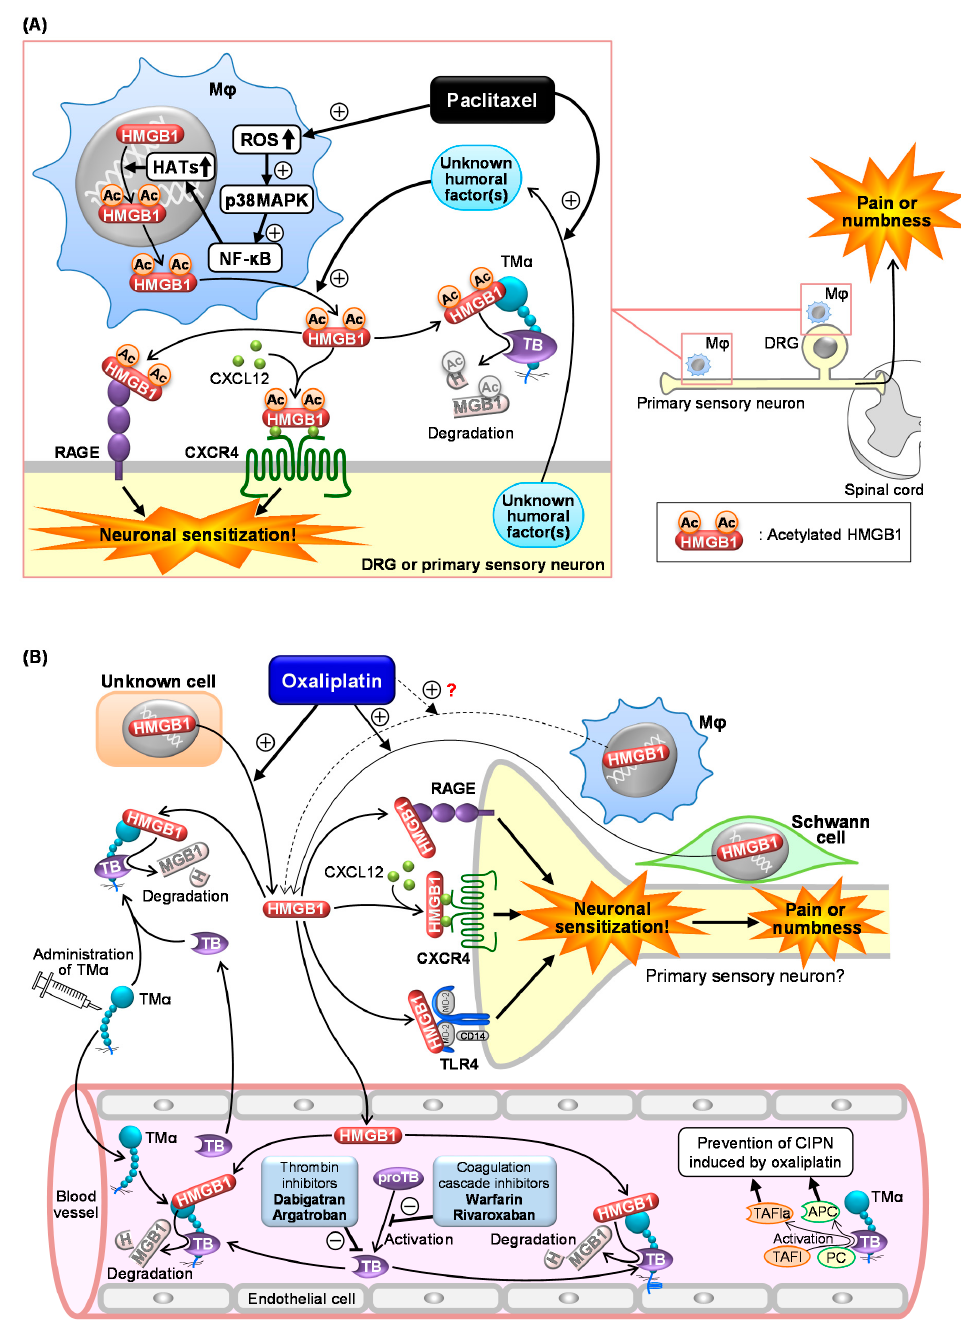
Figure 2. Scheme of the mechanisms underlying chemotherapy-induced peripheral neuropathy (CIPN) in mice treated with paclitaxel ( A ) or oxaliplatin ( B ). ( A ) Paclitaxel causes macrophage (M φ ) accumulation in the dorsal root ganglion (DRG) and sciatic nerves (primary sensory neurons) and upregulates histone acetyltransferases (HATs) via the ROS/p38MAPK/NF- κ B pathway, resulting in acetylation and cytoplasmic translocation of nuclear HMGB1 followed by its secretion. Unknown humoral factors released from neurons in response to paclitaxel promote the HMGB1 release from M φ . The secreted HMGB1 causes neuronal excitation through activation of RAGE, TLR4, and the CXCL12/CXCR4 axis, leading to CIPN characterized by pain or numbness. TM α prevents CIPN following paclitaxel treatment by degrading extracellular HMGB1 in a thrombin (TB)-dependent manner. ( B ) Oxaliplatin induces HMGB1 release possibly from multiple cells including Schwann cells, leading to CIPN through neuronal sensitization via activation of RAGE, TLR4, and CXCL12/CXCR4 pathways. Exogenously applied TM α and endothelial TM accelerate thrombin-induced degradation of HMGB1, thereby reducing the CIPN induced by oxaliplatin. Anticoagulants such as dabigatran, argatroban, warfarin, and rivaroxaban reduce the thrombin-dependent degradation of HMGB1 by TM and TM α , thereby aggravating CIPN and cancelling the anti-CIPN effect of TM α